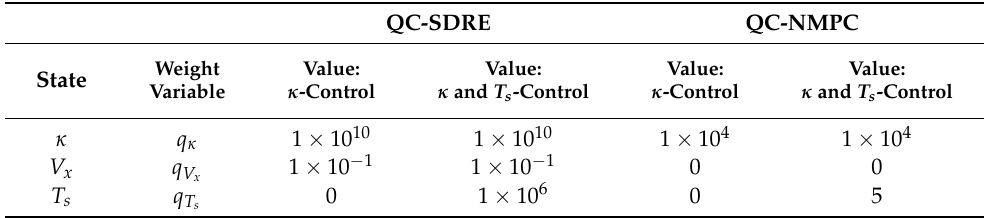
Table 3. Quarter-car (QC) controller